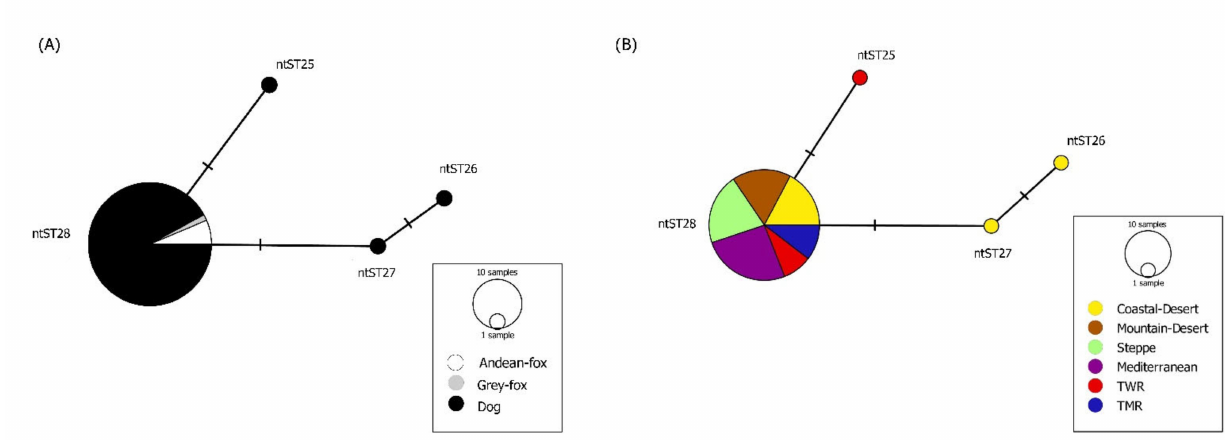
Figure 4. ( A ) Median-joining network of the 16S rRNA gene (312bp) of Candidatus Mycoplasma haematoparvum in rural dogs and wild foxes. The color of the circles corresponds to the species addressed. ( B ) Median-joining network of the 16S rRNA gene (312bp) of Candidatus Mycoplasma haematoparvum in rural dogs from different bioclimatic regions. The color of the circles corresponds to the species assessed or bioclimatic region were the ntST were detected. Each circle in the networks corresponds to a different nucleotide sequence type (ntST), and the size of the circles corresponds to ntST frequencies. No network exclusive of Candidatus Mycoplasma haematoparvum sequences from foxes is presented due to the presence of a single ntST in these